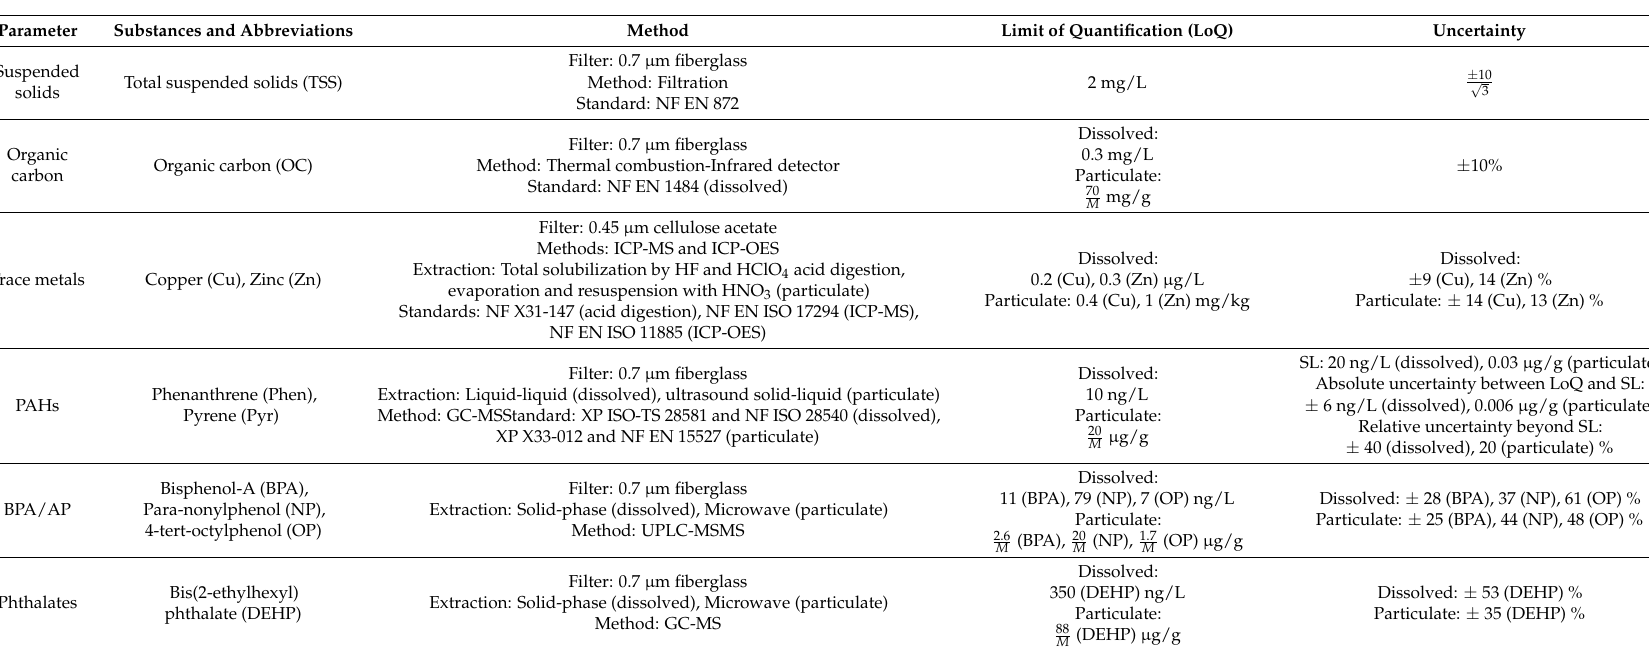
Table 2. Summary of employed analytical methods. M is the mass of TSS extracted in mg, which varied according to the concentration of TSS in the water sample and the filtered volume. Abbreviations: ICP-OES (inductively coupled plasma optical emission spectroscopy), ICP-MS (inductively coupled plasma mass